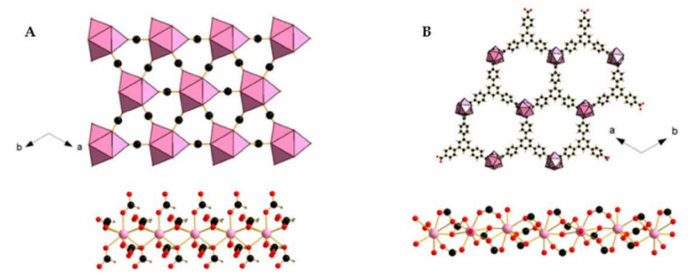
Figure 4. The structure of Nd(form) 3 ( A ) and MIL-103(Nd) ( B ) pre-catalysts for polymerization [68]. Copyright 2016, American Chemical Society.